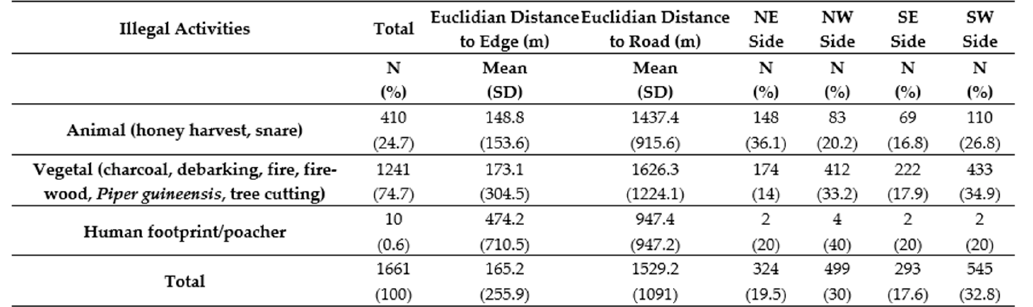
Figure A5. Number of illegal activities collected by SCP (29/05/2015–30/11/2016) per section of Sebitoli area, Kibale National Park, Uganda.